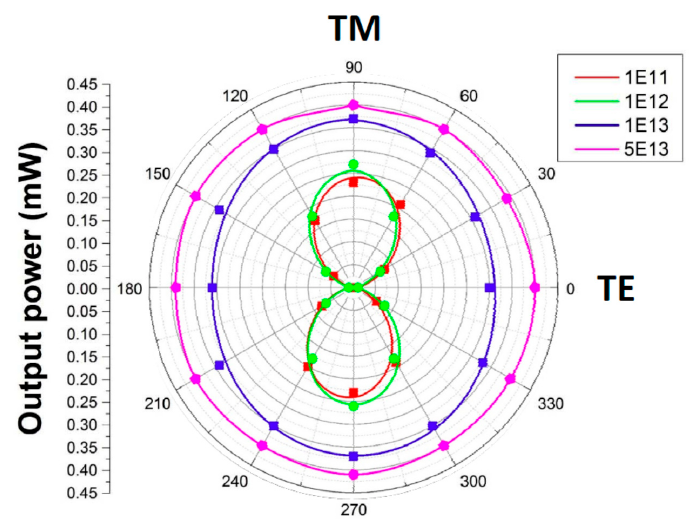
Figure 7. The total output power of the waveguide through the end-surface was plotted with changing the polarization angle of the incident laser. The incident laser power was set to 1.8 mW. The samples were irradiated with 200 MeV Xe 14+ ions at four different fluences; 1 × 10 11 , 1 × 10 12 , 1 × 10 13 , and 5 × 10 13 ions/cm 2 .